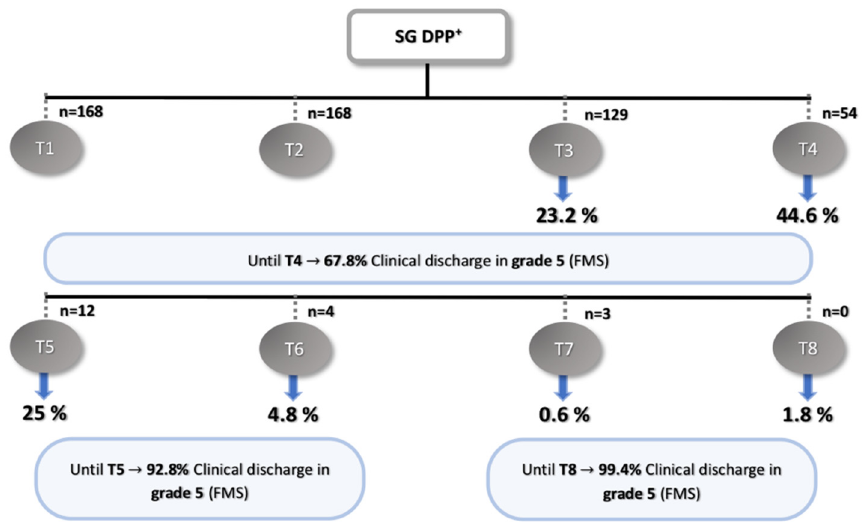
Figure 6. Flow diagram describing the results of the DPP + dogs in the study group. SG: study group, DPP + : deep pain perception-positive, T1: admission, T2: day 3, T3: day 7, T4: day 15, T5: day 30, T6: